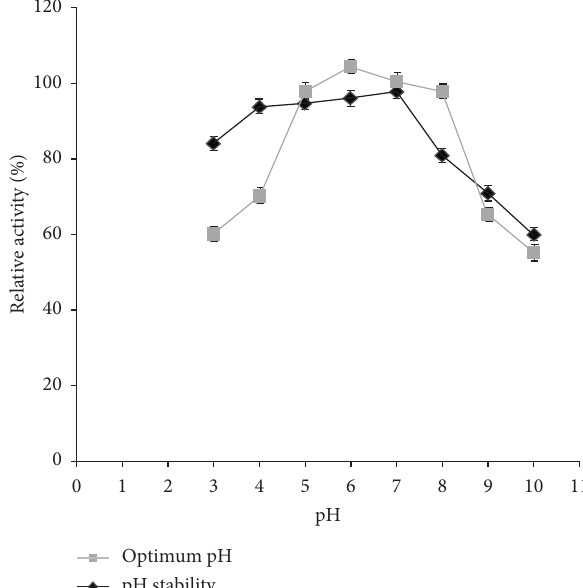
Figure 9: Effect of pH on the activity and stability of dextranase from Talaromyces sp. optimum pH :activity was assayed by the standard method at various pH values. pH stability: activity was assayed by the standard method after incubating the purified dextranase enzyme at different pH values for 1 h at 37 ° C without substrate addition. Error bars represent standard